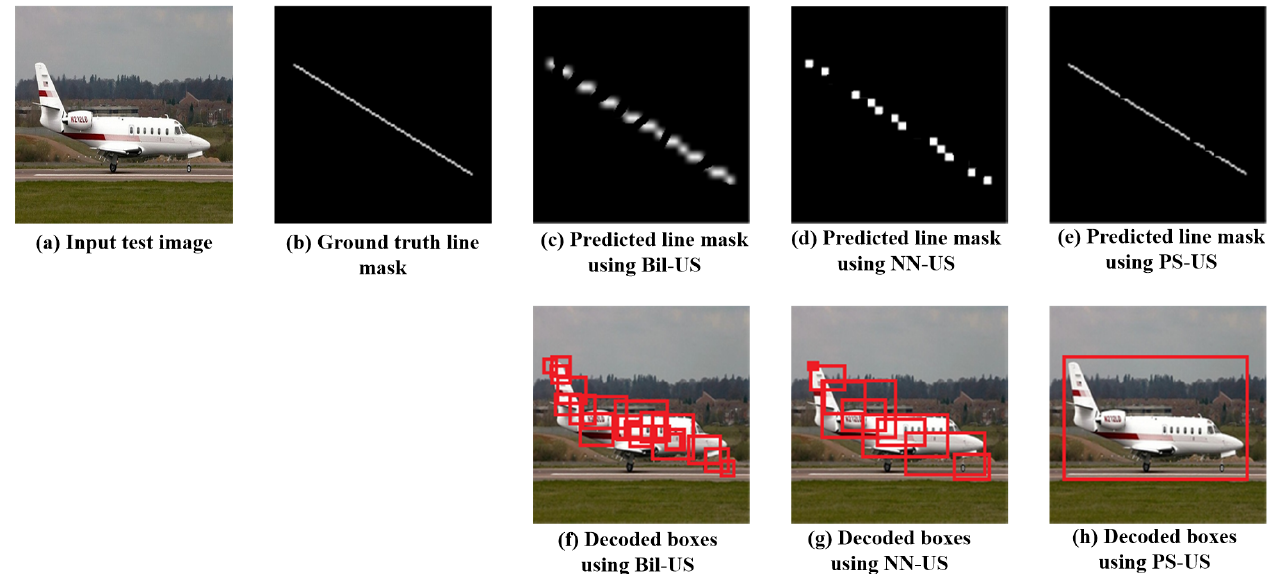
Figure 7. Comparison between the predicted line mask and the decoded boxes in case of using the bilinear up-sampling (Bil-US), nearest neighbor up-sampling (NN-US), and pixel-shuffle up-sampling